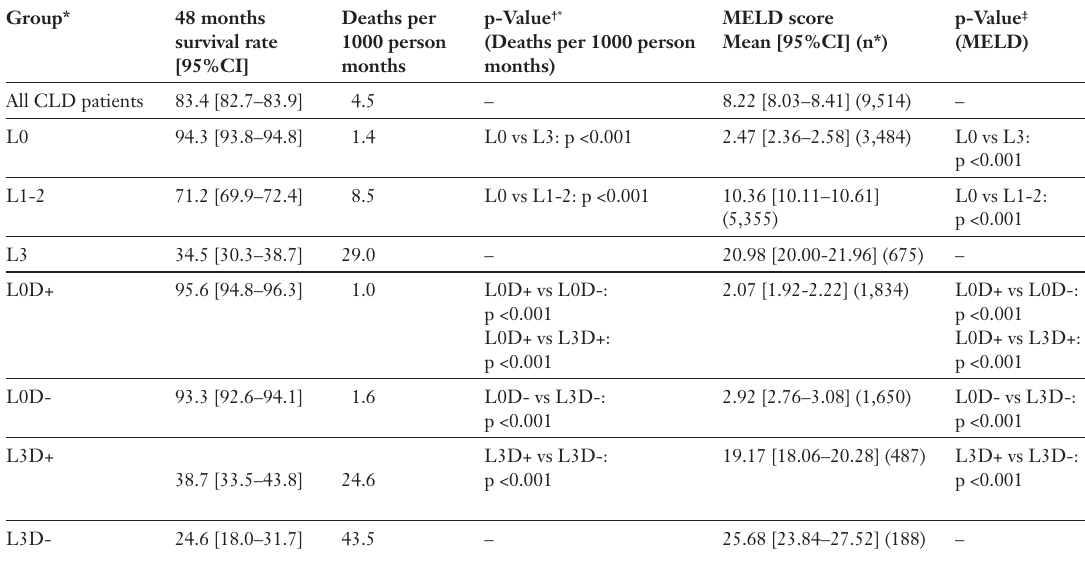
Unadjusted 48 months survival rates and mortality in end stage liver disease (MELD) scores.